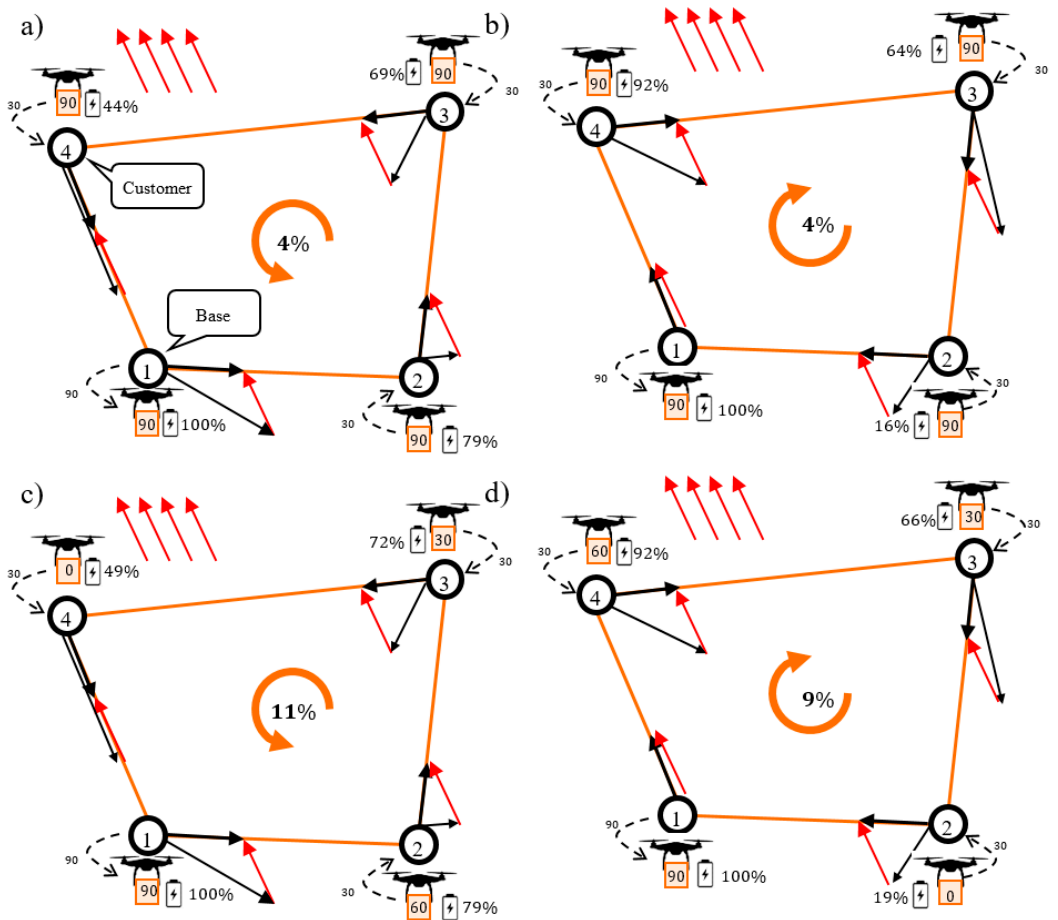
Figure 3. Energy consumption under a constant Unmanned Aerial Vehicles (UAV) weight ( a , b ), and under a variable UAV weight ( c , d ).